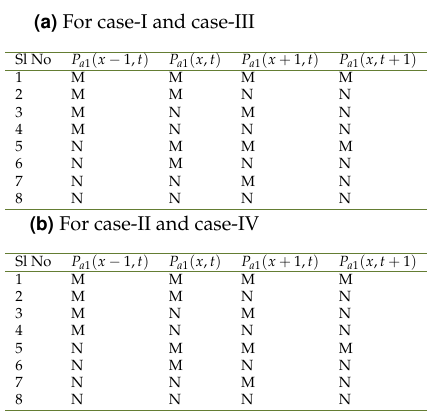
Table 2. Cellular automata approach to calculate pressure variations when R a 1 ( x , t ) = P a 1 ( x , t